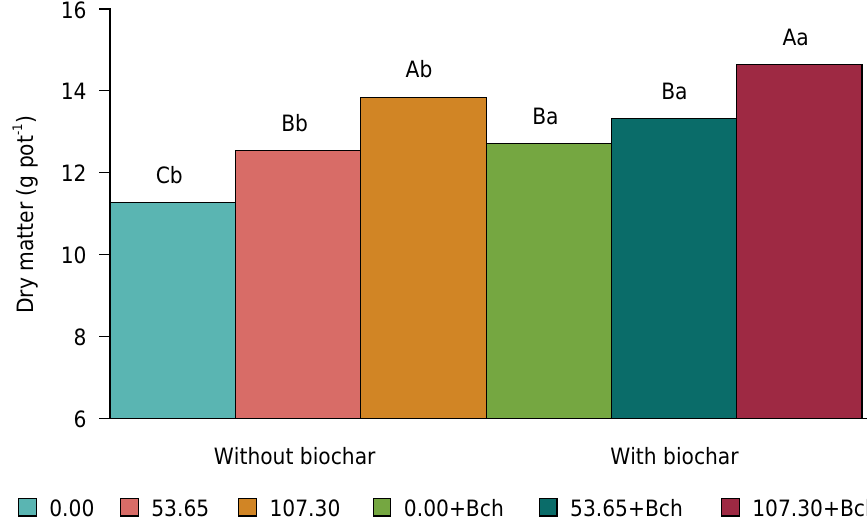
Figure 2. Shoot dry matter of mucuna plants grown in soil treated with or without biochar associated with three doses of potassium (mg dm -3 ). Differences between the three K doses for treatments with or without biochar are indicated by capital letters. Differences between treatments with or without biochar at each dose of K are indicated by lowercase letters, both by Tukey’s test at 5 % (average of 6